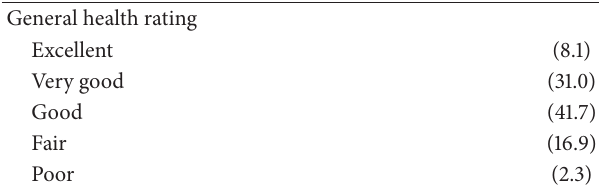
Table 1: Characteristics of the study sample 𝑁 = 529 , ( ) =